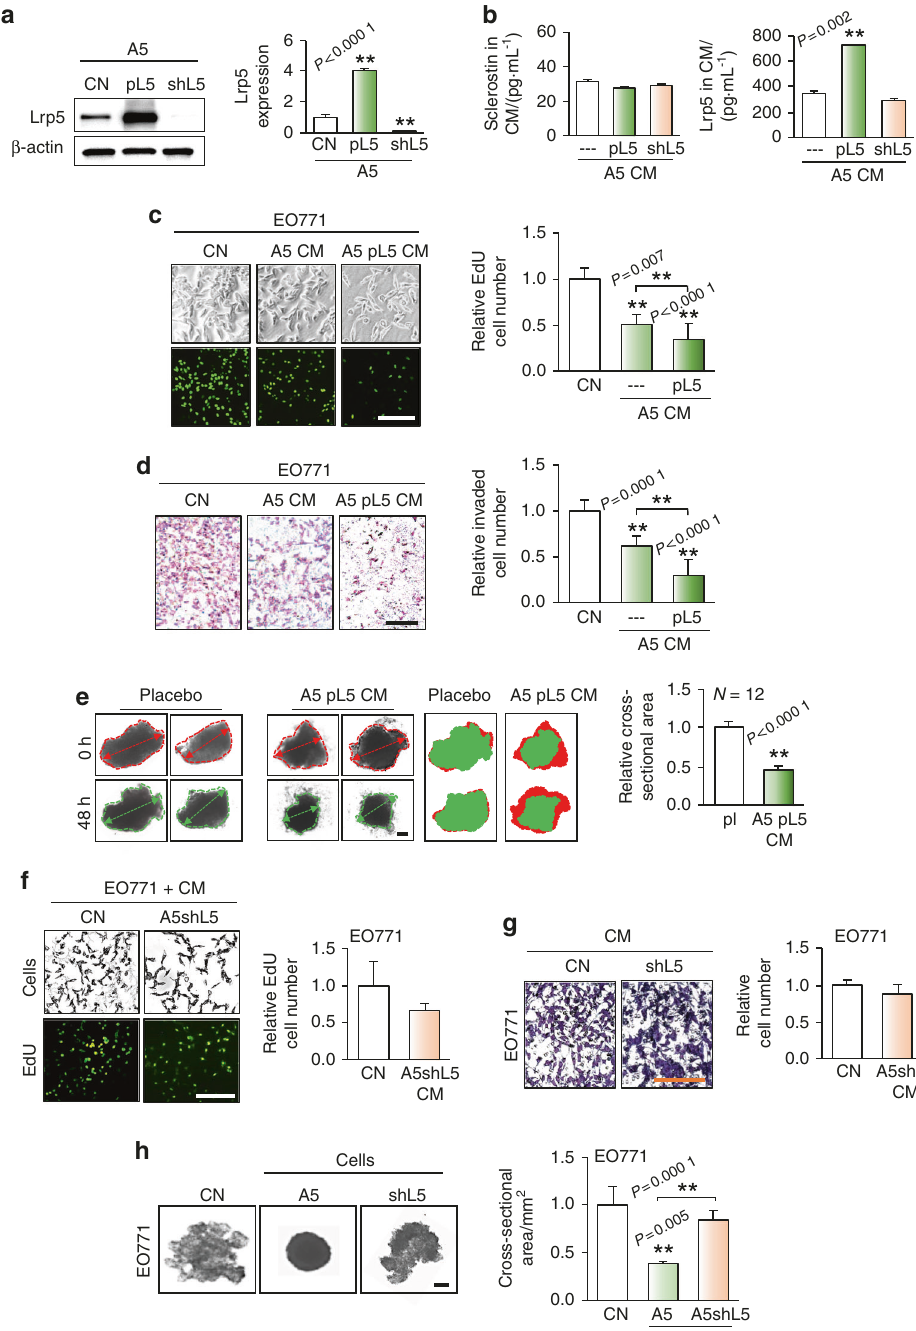
Fig. 3 Enhancement of tumor-suppressive capability by overexpression of Lrp5 in A5 osteocytes. CN control, CM conditioned medium, pL5 Lrp5 plasmids, and shL5 Lrp5 shRNA. The single and double asterisks indicate P < 0.05 and P < 0.01, respectively. a Alteration in the Lrp5 level in A5 osteocytes by overexpression and silencing of Lrp5. b Alterations in the levels of Sclerostin and Lrp5 in A5 CM in response to overexpression and silencing of Lrp5 in A5 osteocytes. c , d Enhanced reductions in the proliferation (as assessed by an EdU incorporation assay) and invasion (as assessed by a Transwell assay) of EO771 cells in response to treatment with CM from Lrp5-overexpressing A5 cells. Scale bar: 200 μ m. e Signi fi cant shrinkage of ex vivo breast cancer tissue fragments induced by treatment with CM from Lrp5-overexpressing A5 cells. The green image at 48 h is overlaid on the red image at 0 h. Scale bar: 200 μ m. f – h Suppression of the antitumor action of A5 CM by silencing Lrp5 in A5 osteocytes, ass assessed by EdU-based proliferation, Transwell invasion, and tumor spheroid assays using EO771 mammary tumor cells. Scale bar: 200 μ osteocyte-derived CM into the proximal tibia markedly protected progression in the tibia in conditional knockout mice. As the bone. In addition to the tumor-driven reduction in BV/TV, we predicted, mice with osteocytic deletion of Lrp5 exhibited also observed a reduction in BV/TV by deletion of Lrp5 in signi fi cantly lower bone mass than their wild-type littermates osteocytes (Supplementary Fig. 4d). However, the tumor-induced (Fig. 4c, d). However, local injection of Lrp5-overexpressing